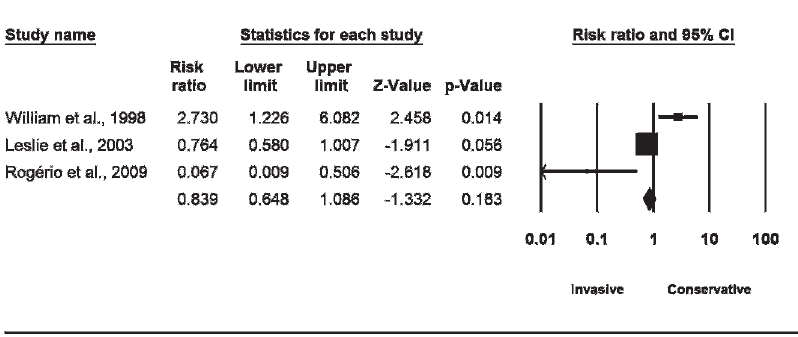
Figure 2 - Primary analysis of the OCS in NSTE-ACS within 30 days.